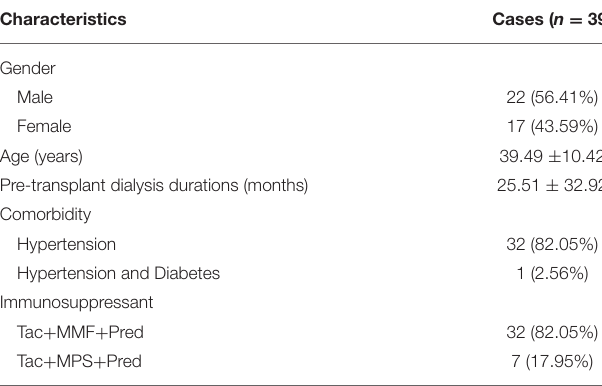
TABLE 1 | Baseline characteristics of participants.